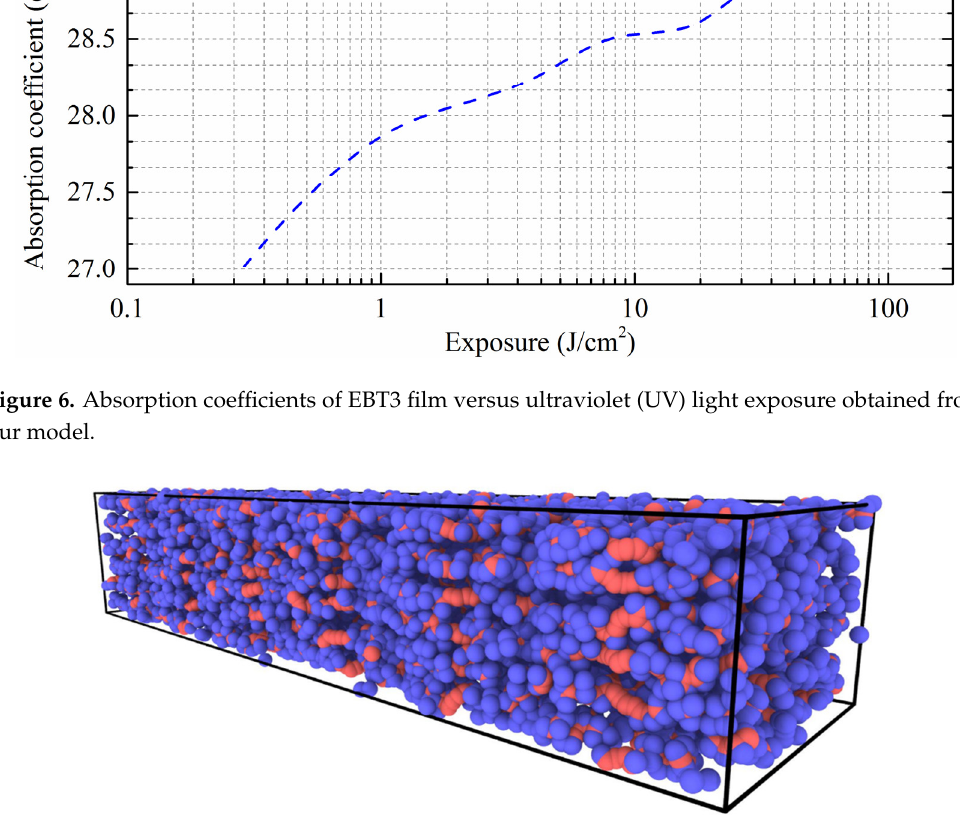
Figure 7. A snapshot from the atomic-scale system of monomer strands during relaxation after UV exposure and subsequent formation of bonds. (Red spheres: carbon atoms; blue spheres: hydrogen atoms. Dimensions of box: 800 × 230 × 150 Å 3 ).